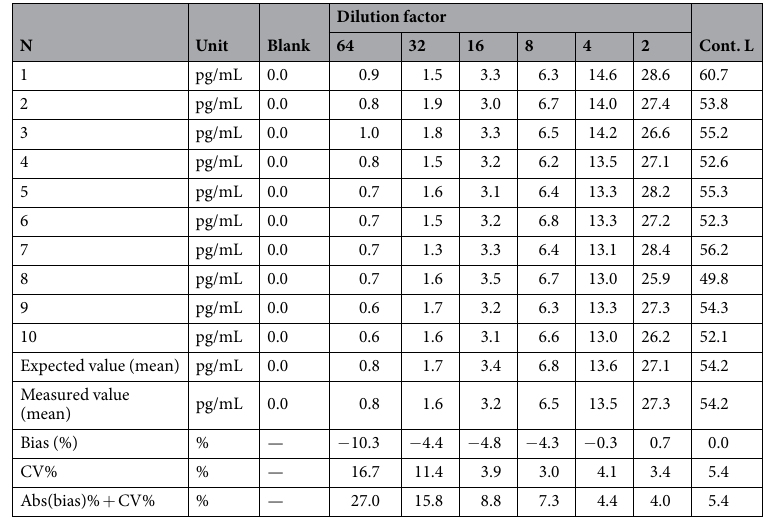
Table 2. Evaluation of the Quantifiable Range of the BNP Assay. The samples were prepared by diluting Control L by dilution factors signified on the top row. CV%, coefficient of variation; abs(bias), absolute value of the bias.